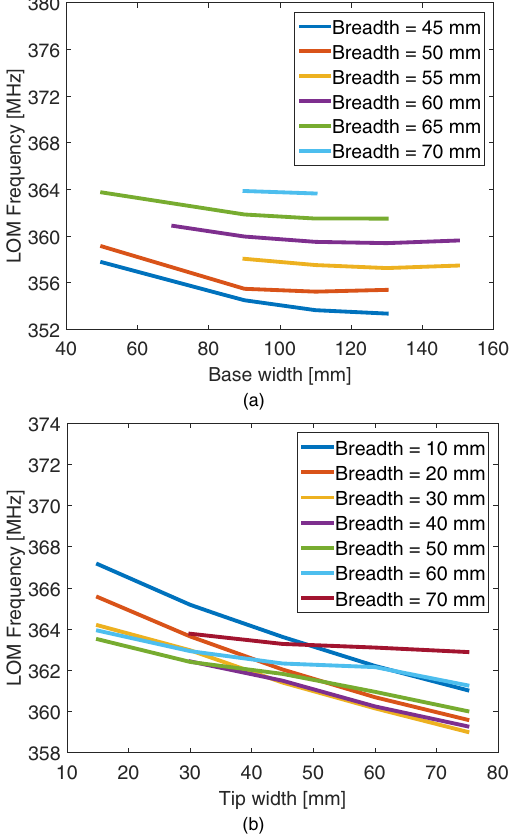
FIG. 12. Frequency of the LOM vs width for different values of breadth for the base (a) and tip (b) ellipses.